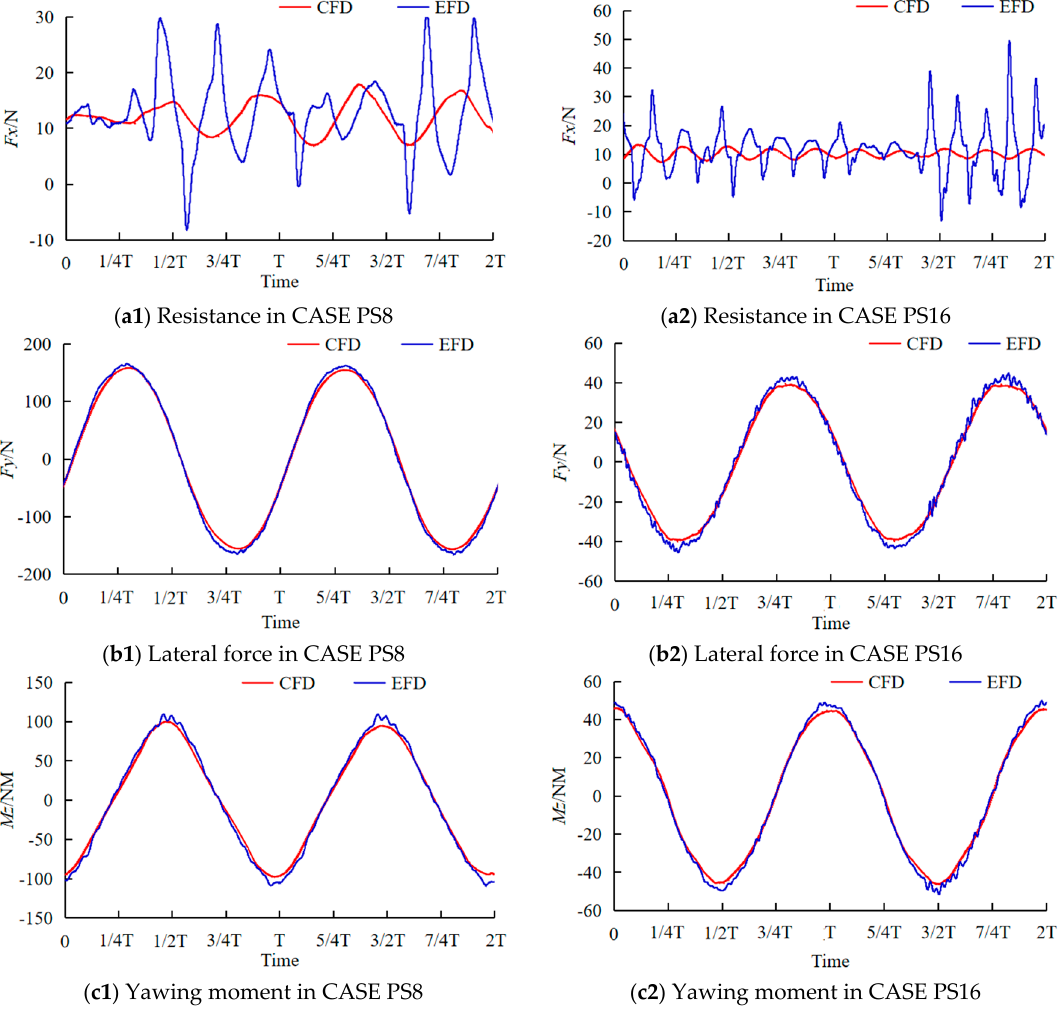
Figure 11. Forces and moment in CASE PS8 (left) and PS16 (right) ( a : resistance; b : lateral force; c : yawing moment). Table 6. Comparison between the calculated and experimental forces and moment in pure sway tests.